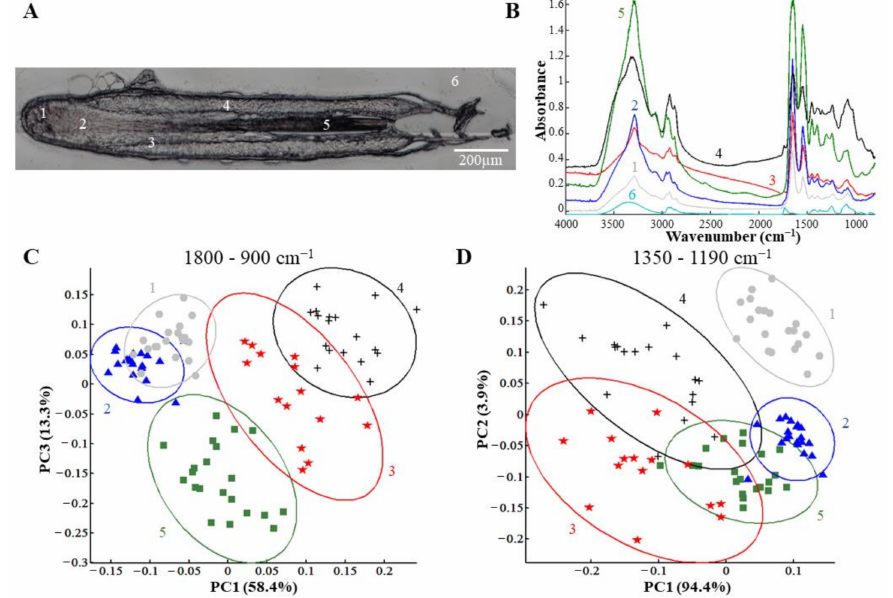
Figure 2. PCA analysis of spectra from specific hair follicle regions. ( A ) White light image of a hair follicle. Five hair follicle structures were analyzed: 1, germinative matrix; 2, differentiation zone of the matrix; 3, IRS; 4, ORS; 5, hair shaft. The number 6 corresponds to OCT. ( B ) Pixel spectrum representative of each structure and OCT. ( C , D ) PCA score plot performed on normalized mean spectra of the above regions in the 1800–900 cm − 1 ( C ) or 1350–1190 cm − 1 ( D ) range and carried out on anagen A1/A3, catagen C1/C3, and telogen T1/T3 hair follicles. Ellipses represent the 95% confidence